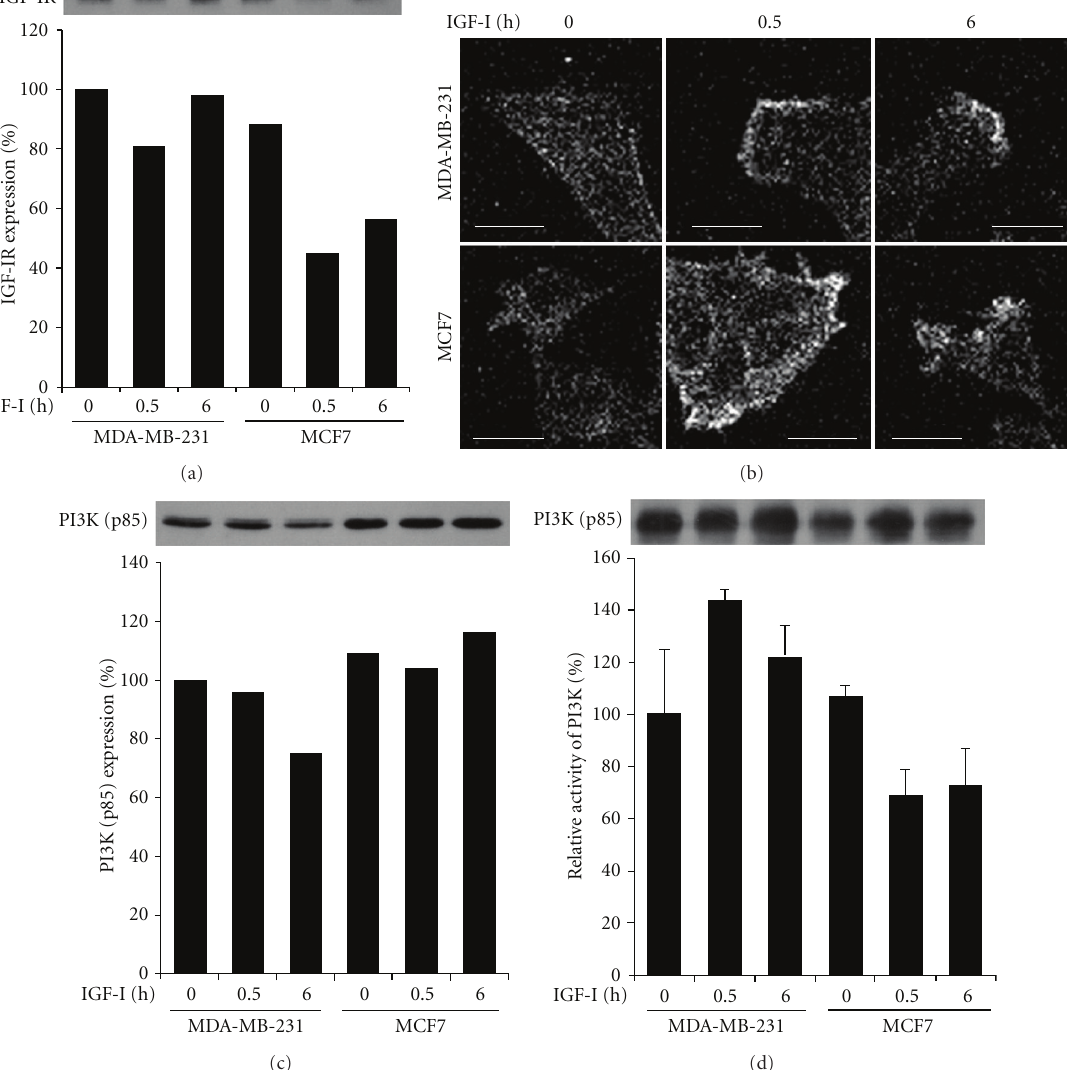
Figure 2: Expression and activation of IGF-IR and PI3K in MDA-MB-231 and MCF7 cells. (a) After stimulation with IGF-I for 0, 0.5, or 6h, cells were lysed and processed for immunoblotting with anti-IGF-IR antibody. Values are given as band intensity relative to that in unstimulated control MDA-MB-231 cells. (b) After stimulation with IGF-I, cells were immunostained with antibody to phospho-IGF-IR (Tyr1135/1135). Scale Bars 20 μ m. (c) After stimulation with IGF-I, cells were lysed and processed for immunoblotting with anti-PI3K (p85) antibody. Values are given as band intensity relative to that in unstimulated control MDA-MB-231 cells. (d) Cells after stimulation with IGF-I were lysed and immunoprecipitated with anti-PI3K (p85) antibody. PI3K activity was assayed for the immunoprecipitates as described in Materials and Methods. The mean (SD) values of triplicate assays are given as activity relative to that in unstimulated control MDA-MB-231